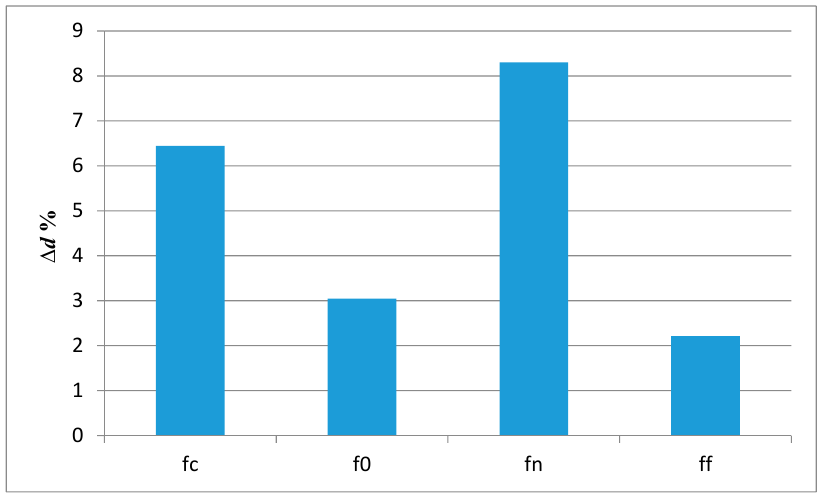
Figure 20. Variation of the ∆ d for 20% change in each constants of GNT model.